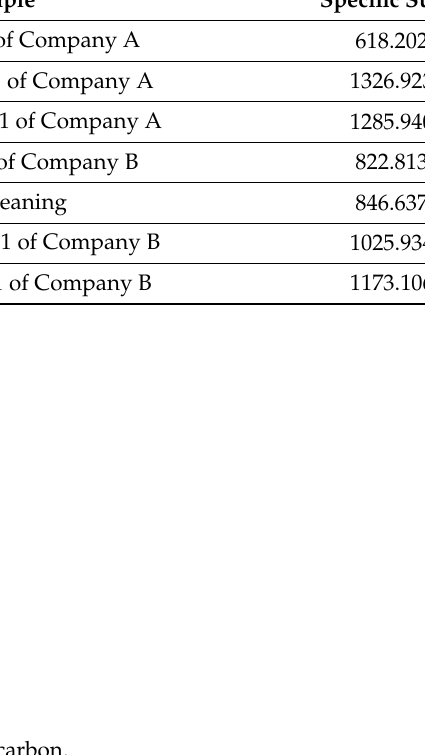
Table 1. Activated carbon specific surface area.